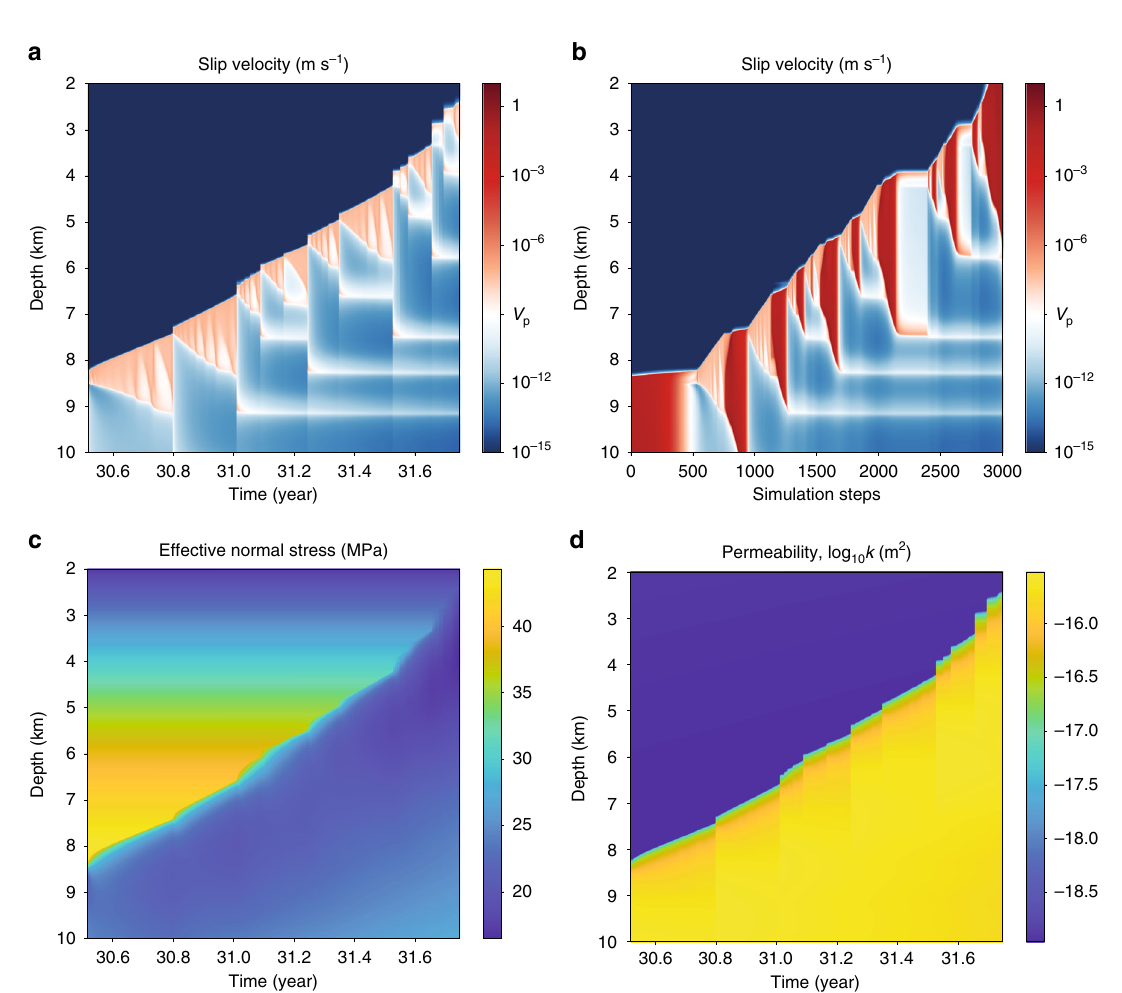
Fig. 4 Zoomed-in view of swarm seismicity triggered as the overpressure pulse ascends through the mid-seismogenic zone. Evolution of a , b slip velocity; c effective normal stress; and d permeability.